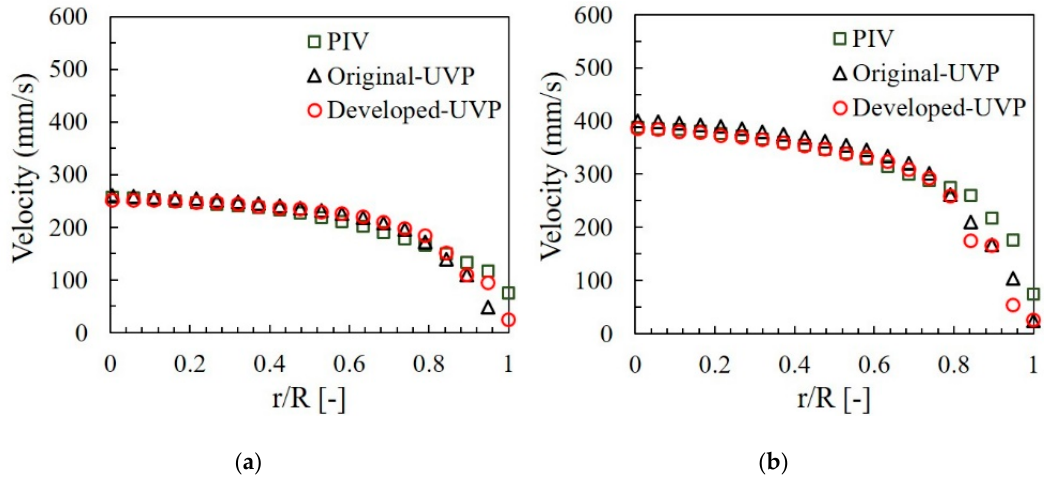
Figure 11. Measurement results for the single ‐ phase liquid velocity profile: ( a ) U L = 200 mm/s and ( b ) U L = 300 mm/s.